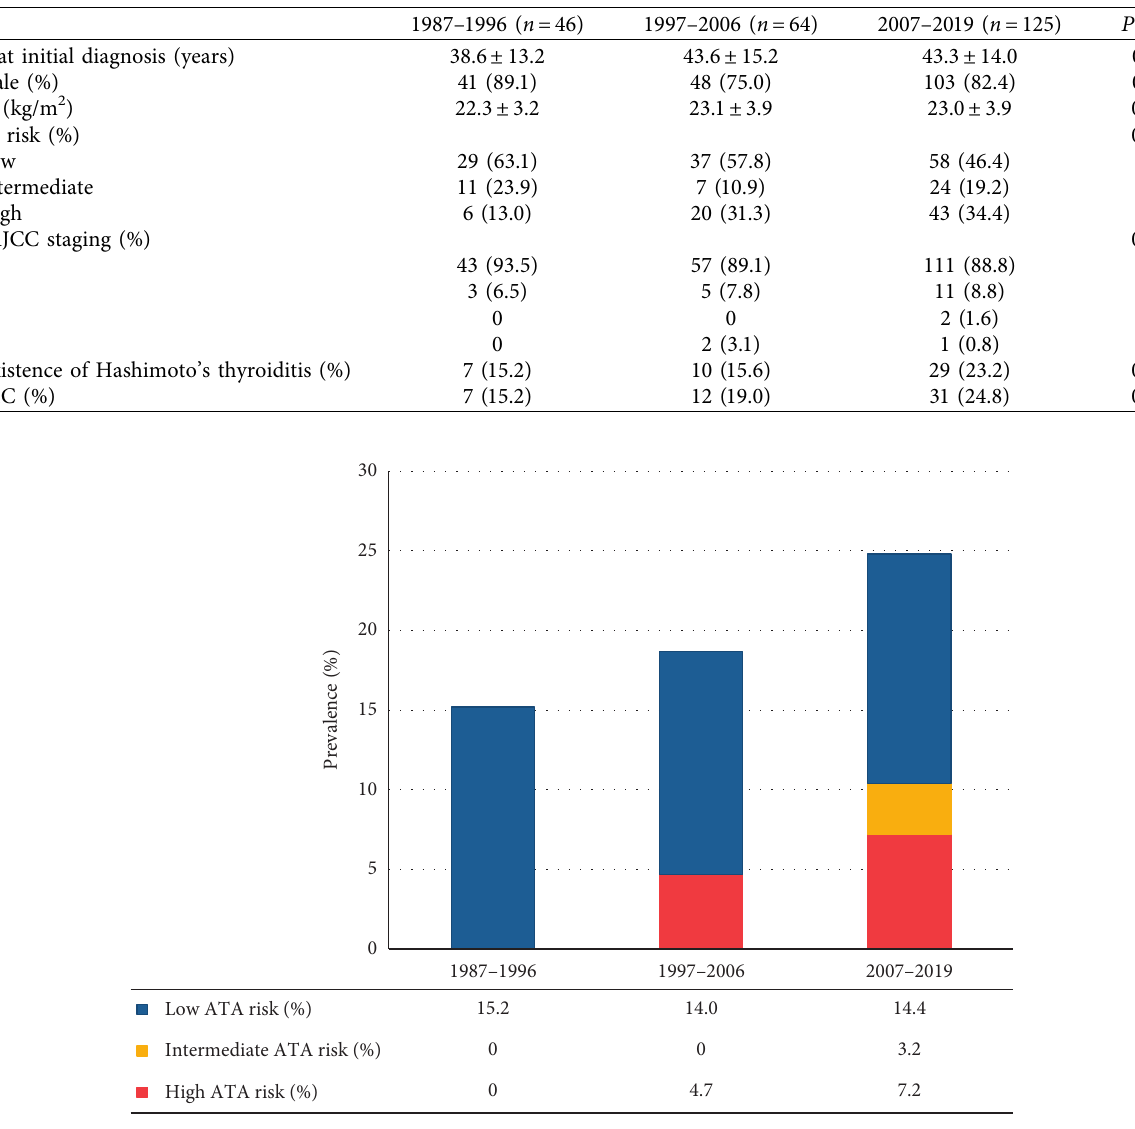
Table 2: Demographic data of papillary thyroid cancer in each decade of the study period.